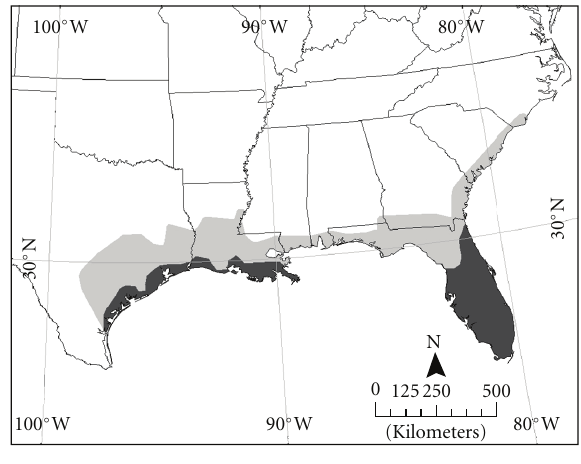
F 1: Map of locations for potential feedstock locations for Eucalyptus in the United States that could be used for bioenergy (as estimated by Kline and Coleman [3] based on the USDA Plant Hardiness Zones [6] and interviews with